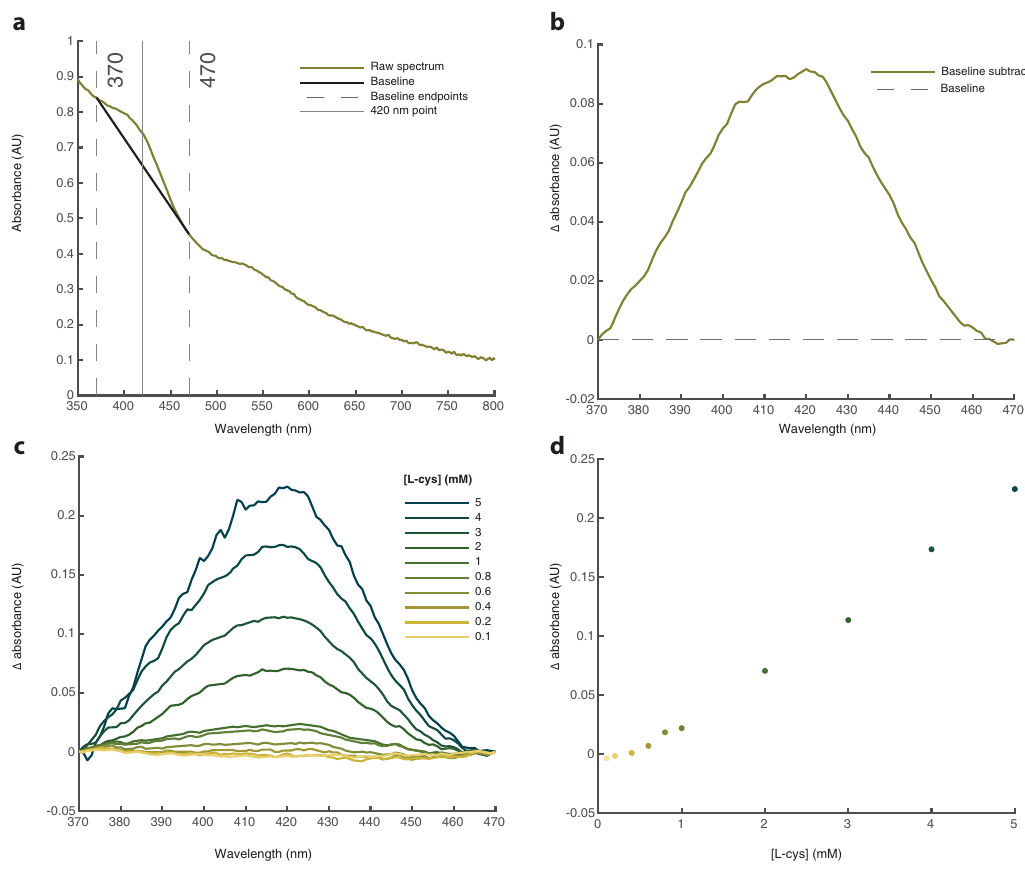
Fig. 3 L-Cysteine promotes the formation of FeS clusters. a Raw UV-Vis spectrum for solution containing 5 mM L-cysteine, 1 mM FeCl 3 and 1 mM Na 2 S at pH 9. The parameters used to extract the 420 nm peak are also displayed. b the extracted 420 nm peak from the raw data in panel ( a ). c extracted 420 nm peak from spectra recorded from solutions containing increasing L-cysteine concentrations ranging from 0.1 to 5 mM at pH 9. Each solution was prepared using a 5:1:1 molar ratio of L-cysteine:FeCl 3 :Na 2 S. d Plot of the extracted 420 nm peak height as a function of L-cysteine concentration from data in panel ( c ). These values are compared with the full curve- fi tting data used to establish concentrations in Fig. 2c. Source data are provided as a Source data fi